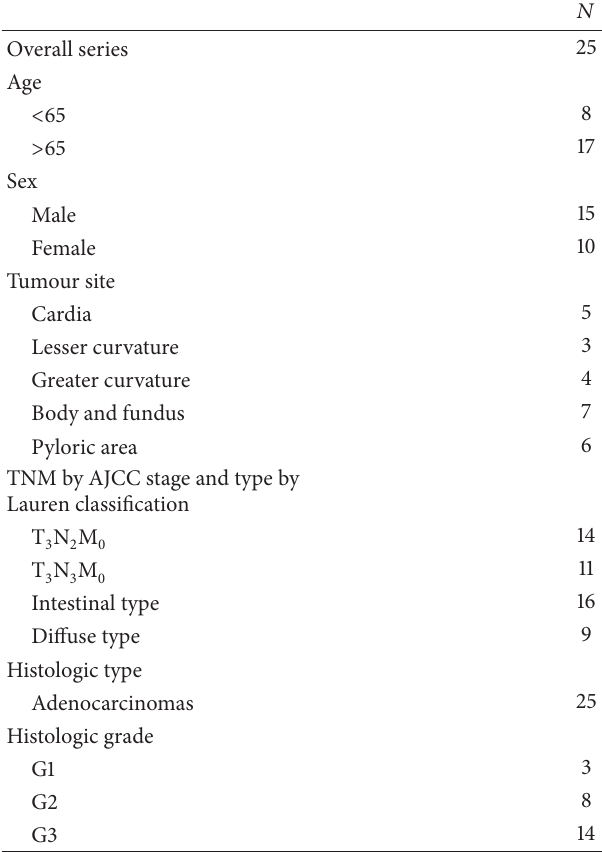
Table 1: Clinicopathological features of